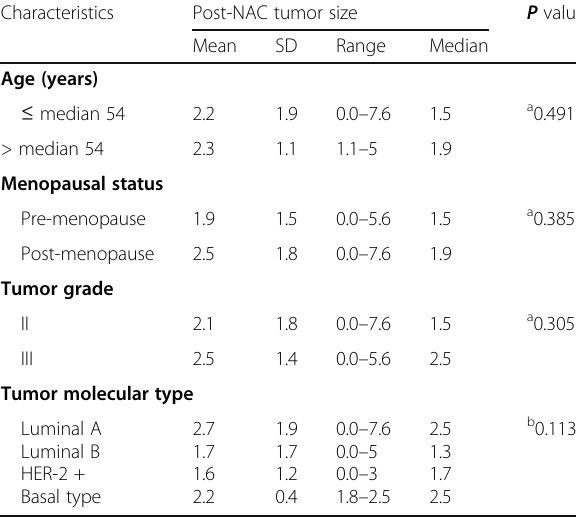
Table 5 Relationship between demographic/histopathologic features and post-NAC tumor size